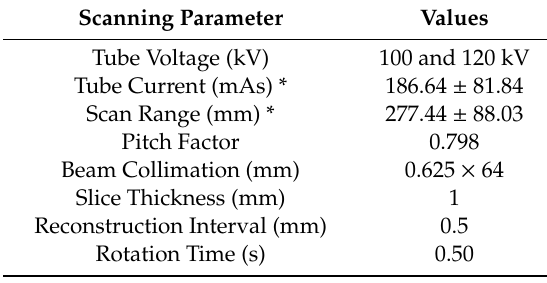
Table 2. Data on the scanning acquisition in computed tomography pulmonary angiography (CTPA) examinations.